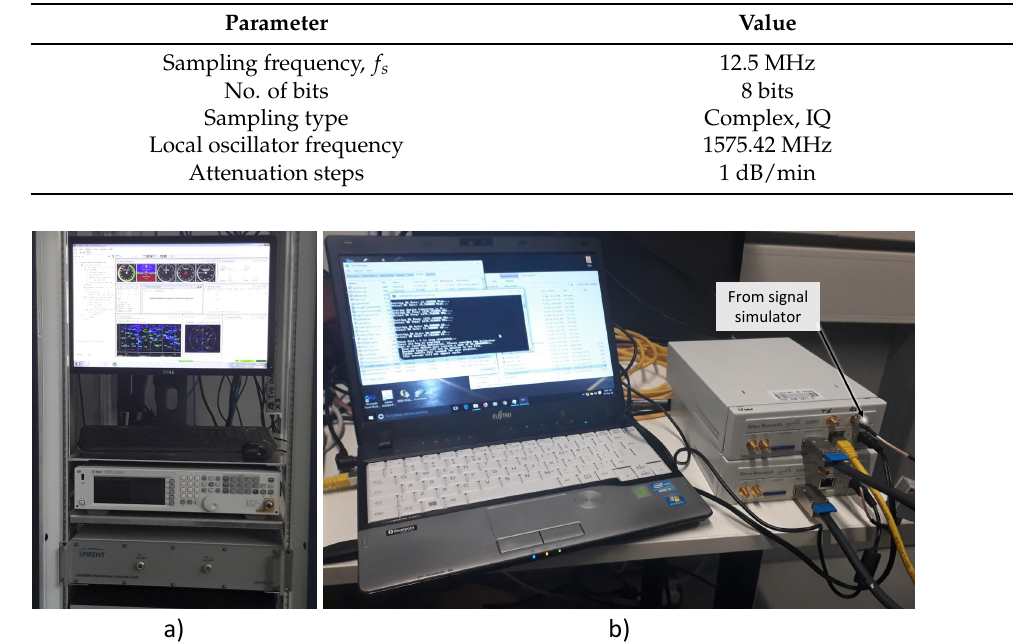
Table 2. Parameters used for the collection of the I/Q data generated using the Spirent GSS9000 simulator.